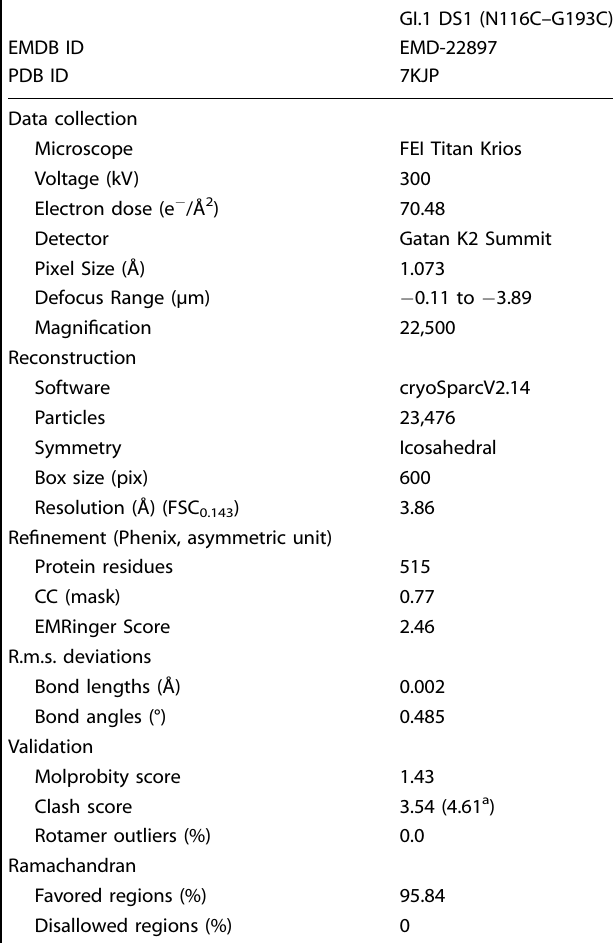
Table 1. Cryo-EM data collection and re fi nement statistics.